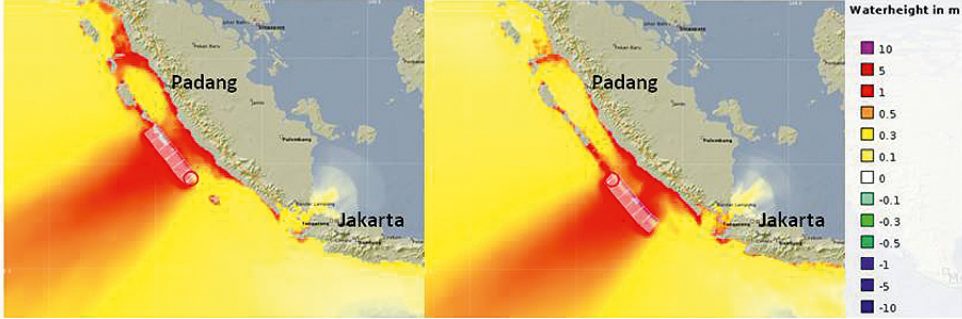
Fig. 4. Tsunami Simulation based on location and magnitude (8.4) of a hypothetical earthquake off-shore Bengkulu, Sumatra. The figure left depicts the situation for the earthquake with a rupture running from the epicentre to the north. Especially the big city Padang is strongly affected, the south of Sumatra is not. The figure on the right hand depicts the situation for the earthquake with a rupture running from the epicentre to the south. Now the City of Padang is not affected but the south of